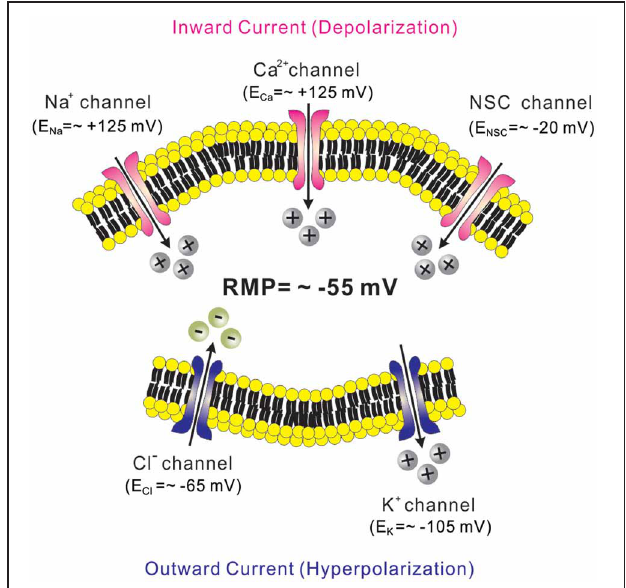
FIGURE 1 | Ion channels and regulation of membrane excitability. Neurons within the arcuate nucleus typically have a RMP of ∼ 55mV ( See text ). Cations rush in through open channels when RMP is more negative to the equilibrium potentials (pink-colored channels). By contrast, cations rush out or anions rush in through open channels when RMP is more positive to the equilibrium potentials (blue-colored channels). Equilibrium potentials were calculated using Nernst equation assuming experimental conditions in Sohn et al.